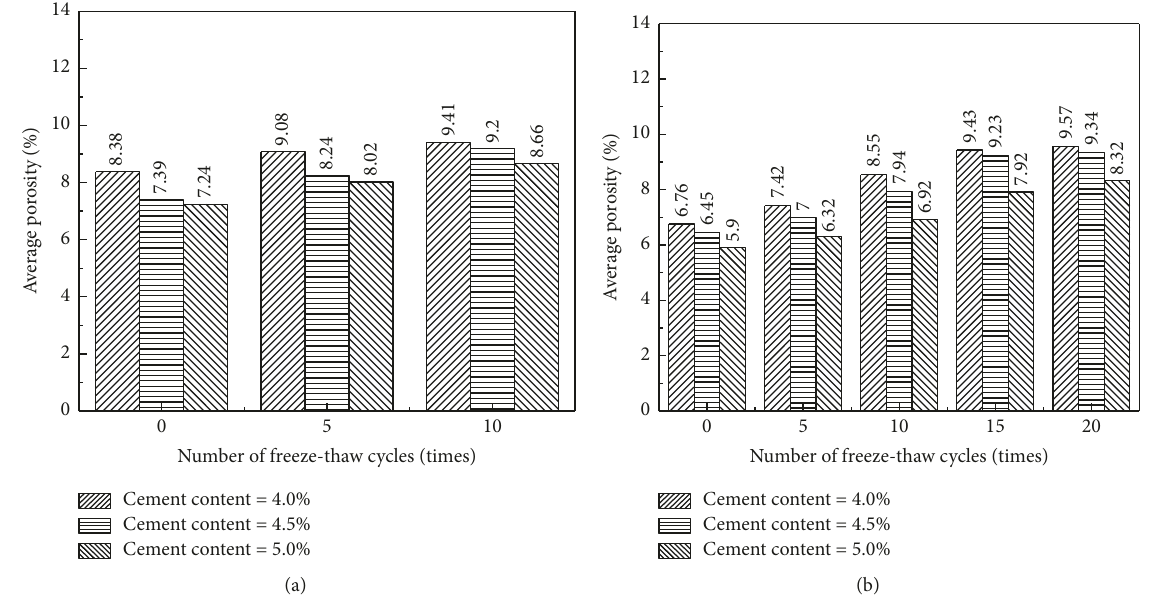
Figure 5: Effect of the freeze-thaw cycle number, cement content, and curing time on the average porosity: (a) curing time = 28 d; (b) curing time = 90 d.